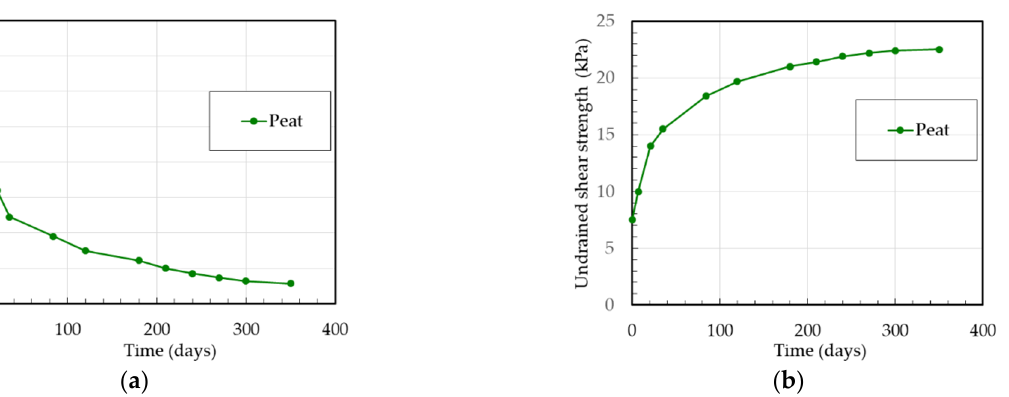
Figure 5. Test embankment No. 2 at the Bia ł o ś liwie site: ( a ) settlement versus time, ( b ) undrained shear strength versus time.